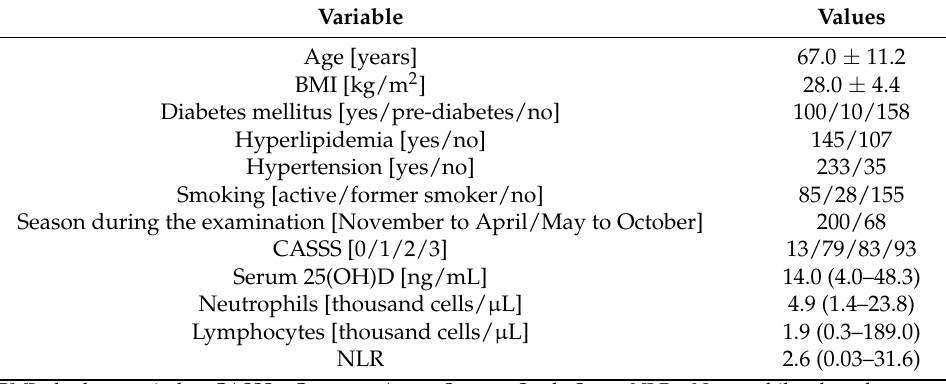
Table 1. Participants’